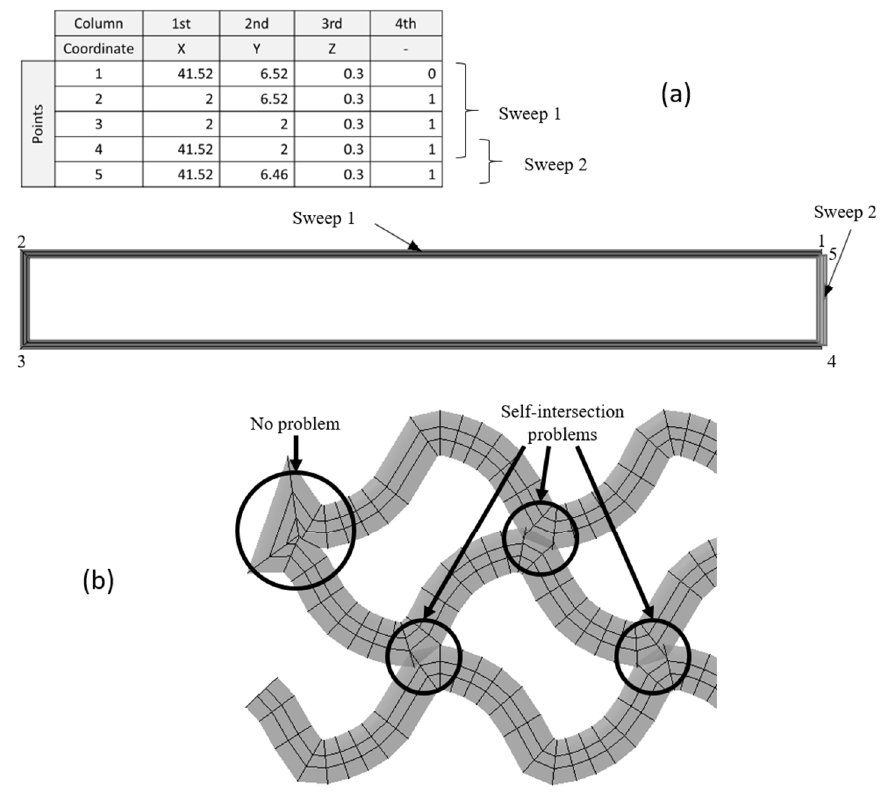
Figure 3. Division of close sweep ( a ) and self-intersection of a gyroid fill pattern ( b ).